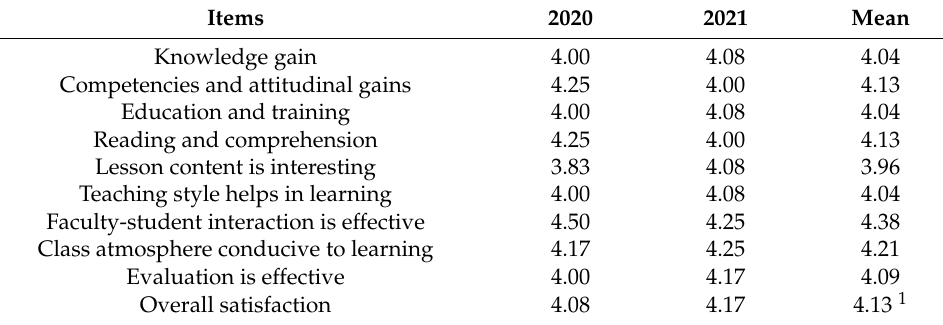
Table 2. Students’ course